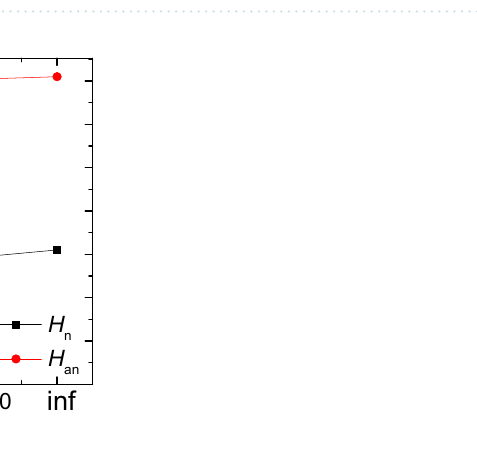
Figure 8. The topological number as a function of H z and the evolution of the magnetic structure during this process in the circular curved film with R = 60 nm.